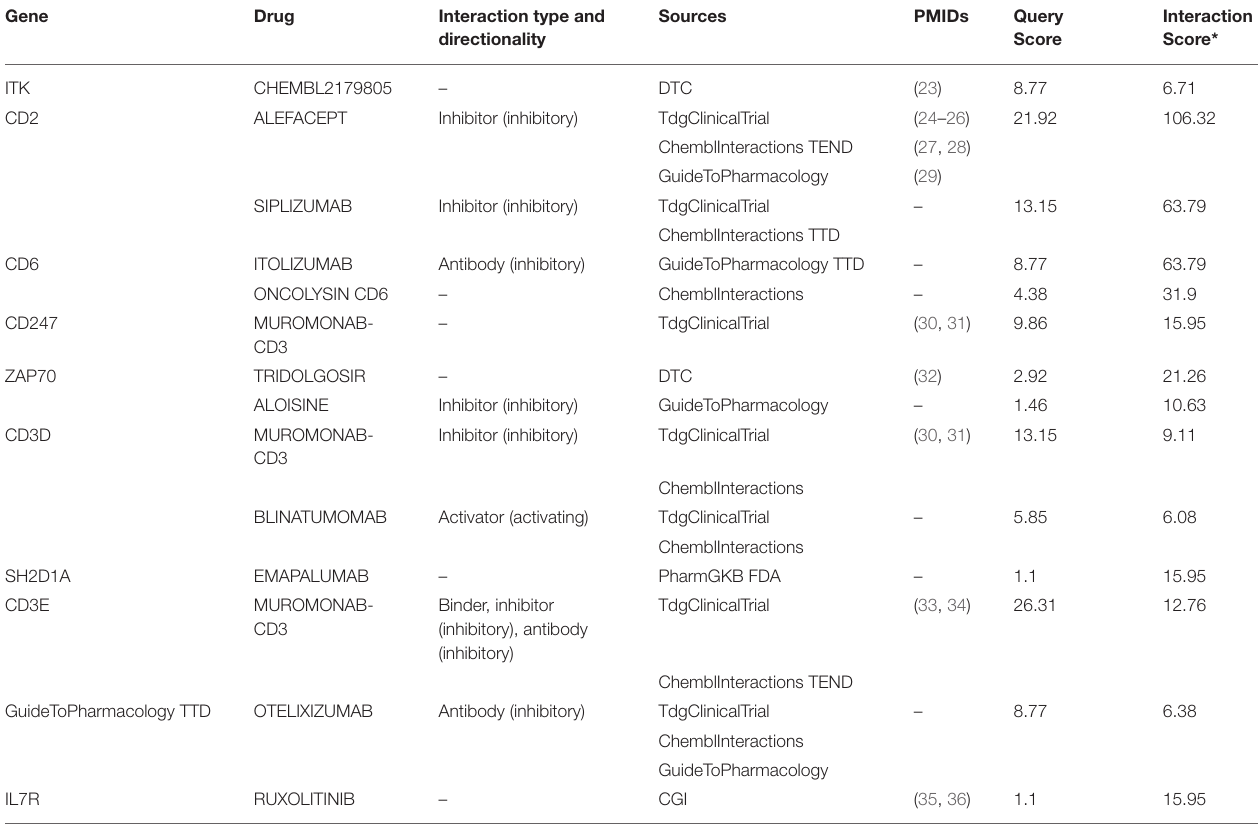
* Drug molecules showing > 5 interaction score is shown